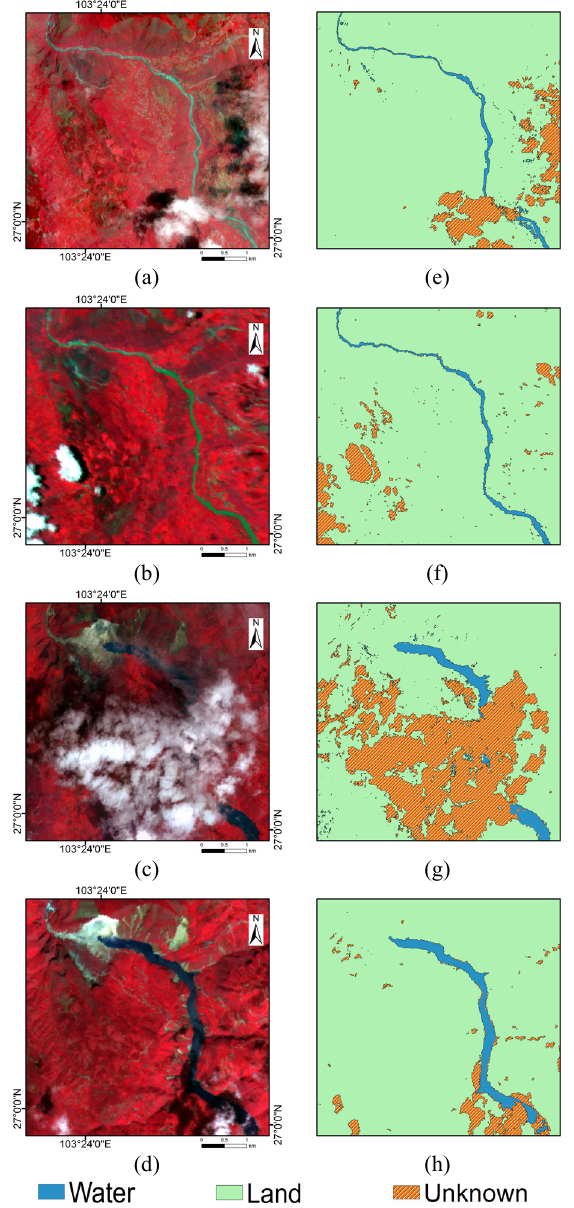
Figure 2. Remote sensing images of the study area (by false colour composition) and their corresponding classification result. (a) Pre-disaster image of 2014-06-25. (b)Pre-disaster image of 2014-07-23. (c) Post-disaster image of 2014-08-05. (d) Post-disaster image of 2014-09-11. (e), (f), (g), (h)